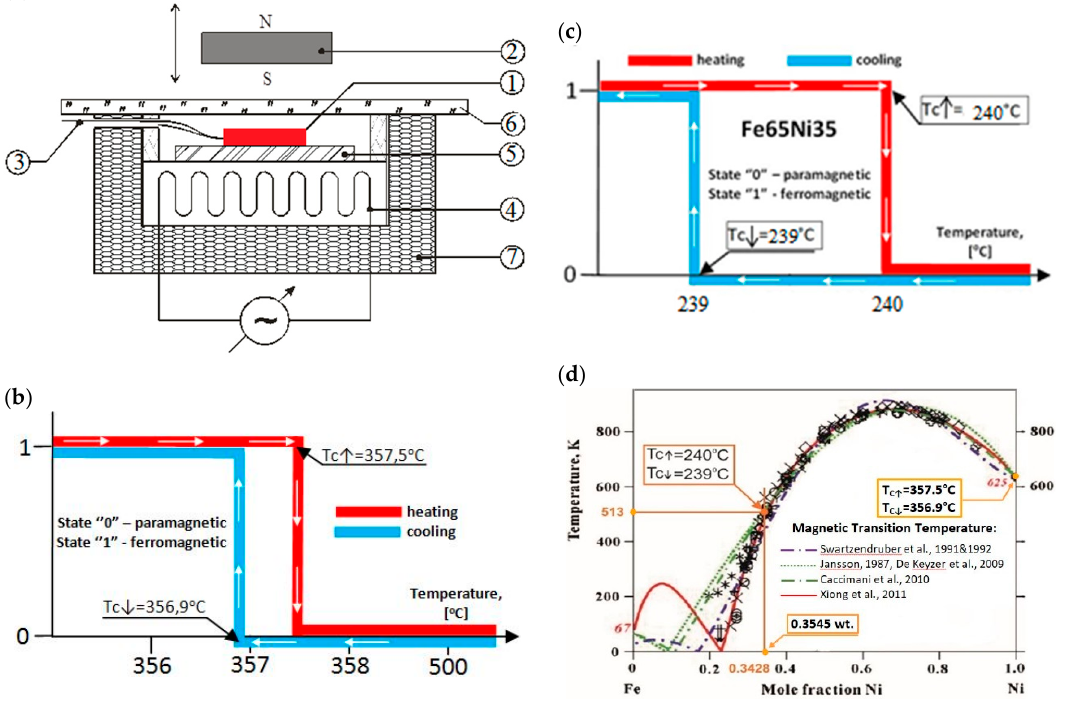
Figure 8. ( a ) Test bench for Curie point of Fe–Ni alloy investigation. 1 (cid:79) Investigated sample, 2 (cid:79) magnet, 3 (cid:79) thermocouple, 4 (cid:79) heater, 5 (cid:79) Cu plate (1.3 mm thick), 6 (cid:79) glass (1 mm thick), 7 (cid:79) insulation. ( b , c ) Preliminary results of Curie point investigation of suitable Ni999 and Fe65Ni35 alloys during sample heating and cooling; ( d ) graph fragment with results of experimental studies and theoretical calculations of the face-centered cubic (FCC) phase transformation of Fe–Ni alloy ([27], Figure 1), with results of T C ↑ and T C ↓ of Fe65Ni35 and Ni999 alloys (ferromagnetic ↔ paramagnetic).